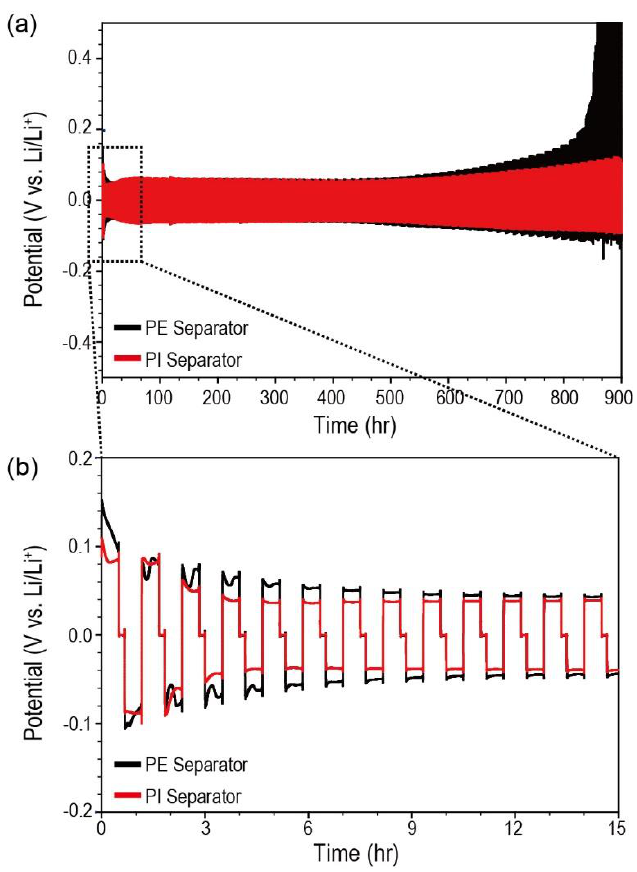
Figure 6. (a ) Potential profiles of Li/Li symmetric cells containing different types of separators (bare separators and porous PI separators) performed based on an iterative loop [ + 0.5 mA cm − 2 (30 min) → PE separators and porous PI separators) performed based on an iterative loop [+0.5 mA cm – 2 (30 min) Rest (10 min) → − 0.5 mA cm − 2 (30 min) → Rest (10 min)]. ( b ) Magnified potential profiles of Li / Li → Rest (10 min) → – 0.5 mA cm – 2 (30 min) → Rest (10 min)]. ( b ) Magnified potential profiles of Li/Li symmetric cells corresponding to Figure symmetric cells corresponding to Figure 6a.